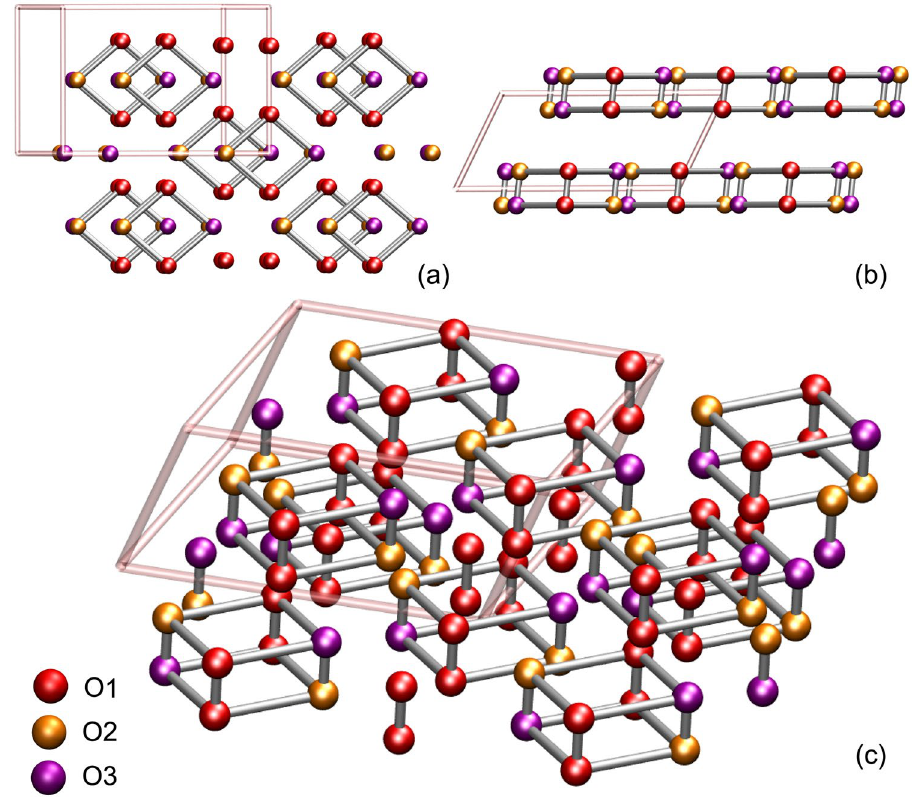
Figure 1. Crystal structure of the ε -phase of solid oxygen. The structure as viewed perpendicular to the a – b ( a ) and a – c ( b ) planes. The O 8 clusters in the monoclinic unit cell (rose lines) are shown in ( c ). O x ( x = 1, 2, 3) label the three inequivalent oxygen